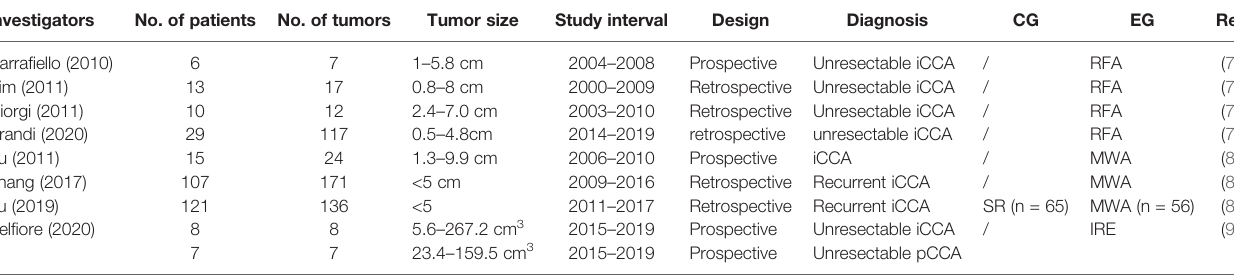
TABLE 3 | Study design and characteristics within included studies for ablation. Investigators